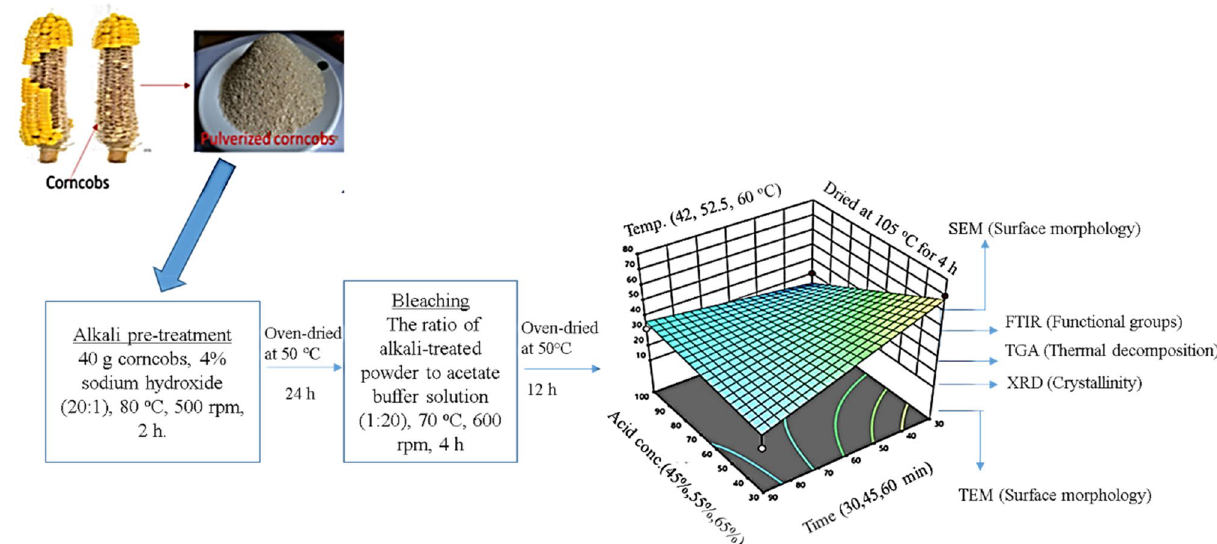
Figure 1. Schematic diagram of the preparation of CNCs from waste South African